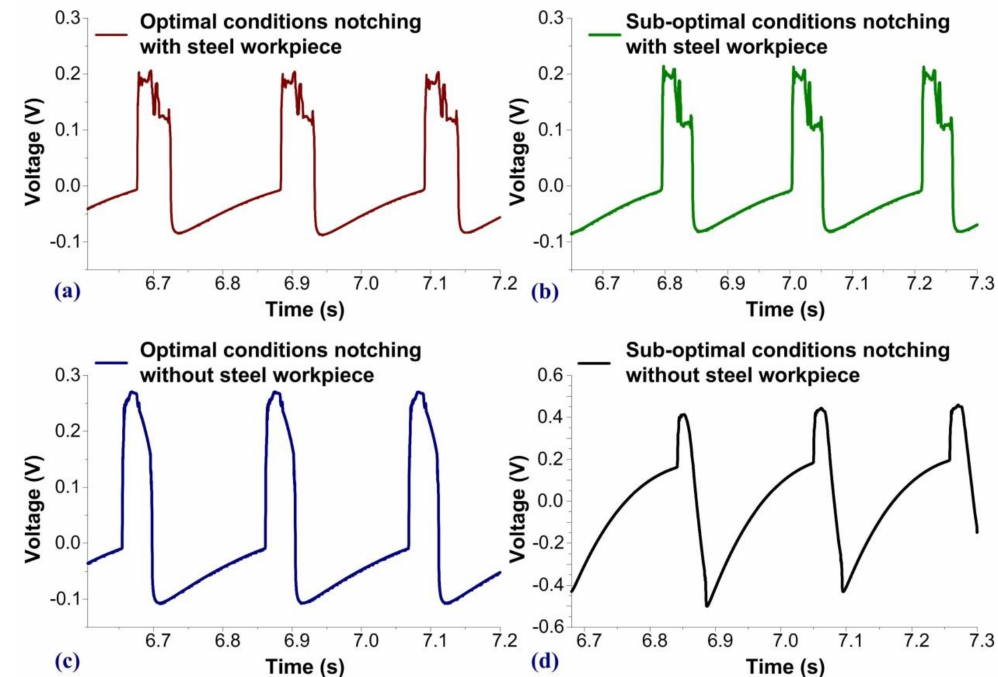
Figure 7. Comparison of PVDF waveforms at microscale: signals obtained with a steel workpiece loaded into the notching machine with ( a ) sharp edges and ( b ) blunt edges; and signals obtained without a steel workpiece loaded into the notching machine with ( c ) sharp edges and ( d ) blunt edges.